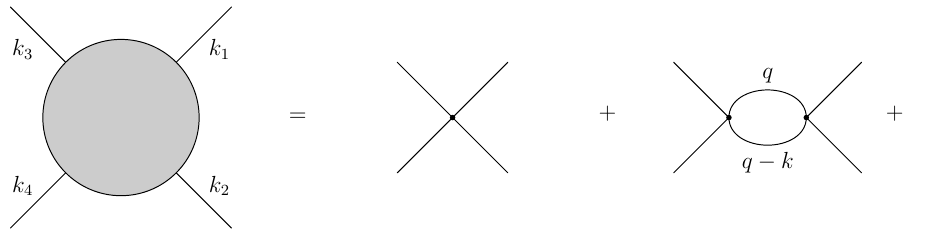
Figure 1 . The one-loop corrections to the four-point correlation function in the interacting scalar (cid:12)eld